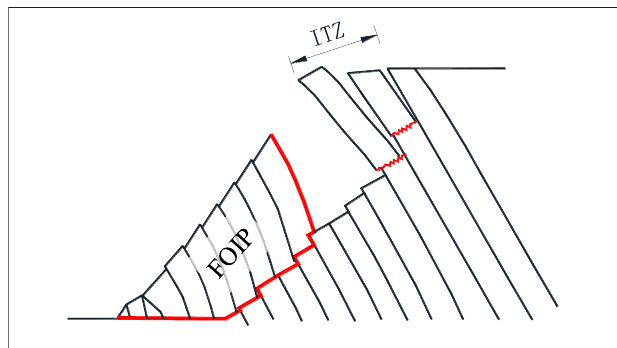
FIGURE 14 | The failure process after the formation of the fi rst-order instability part (FOIP). ITZ: independent toppling zone.